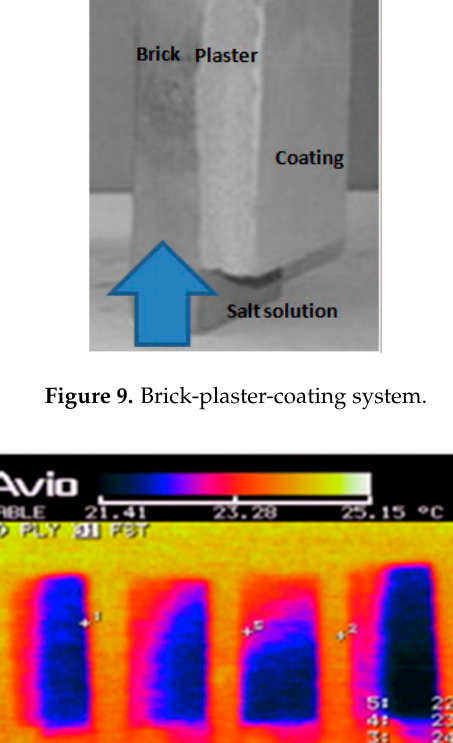
Figure 10. IRT investigation of a salt solution capillary rise test in brick-plaster-coating systems.